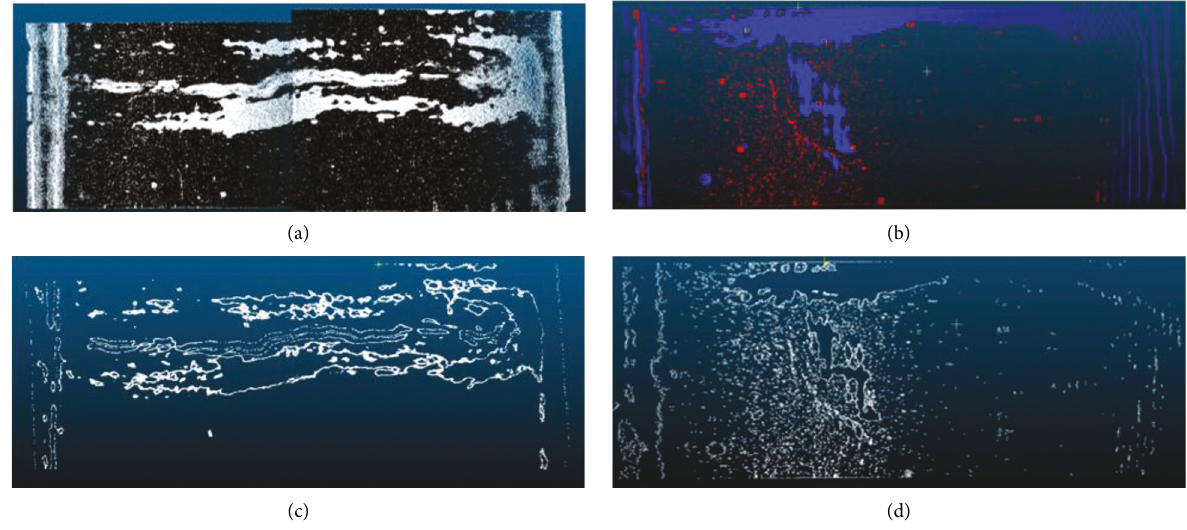
Figure 9: Crack candidate extraction. The binary image of crack points (a, b) and the crack edge (i,